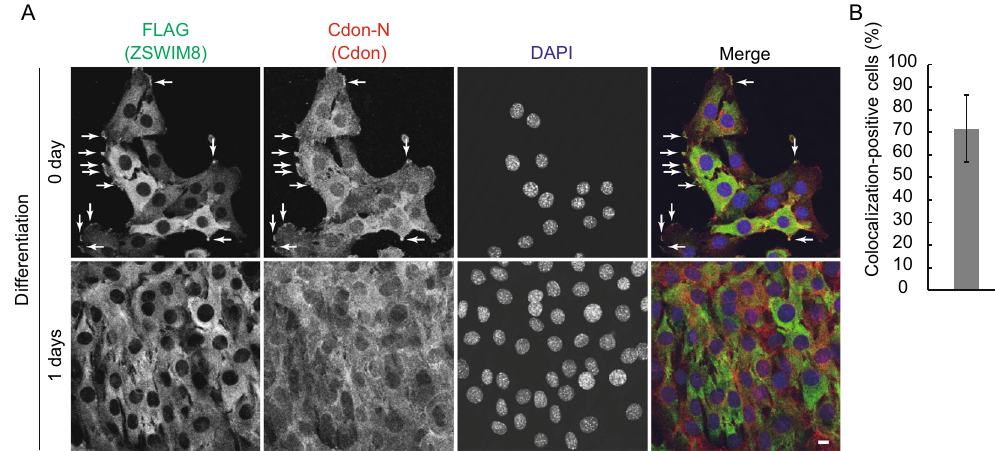
Figure 4. Co-localization of ZSWIM8 and Cdon. ( A ) 3 × FLAG-ZSWIM8-expressing C2C12 cells were immunostained by anti-FLAG and Cdon-N antibodies. Nuclei were stained with DAPI. Scale bar, 10 μm. Representative colocalization in growing cells is indicated by white arrows. Representative data of two independent experiments. ( B ) Quantification of colocalization-positive cells in ( A ). Colocalization-positive cell number was counted and divided by total cell number in four different fields. Data represent the mean ± SD (n =